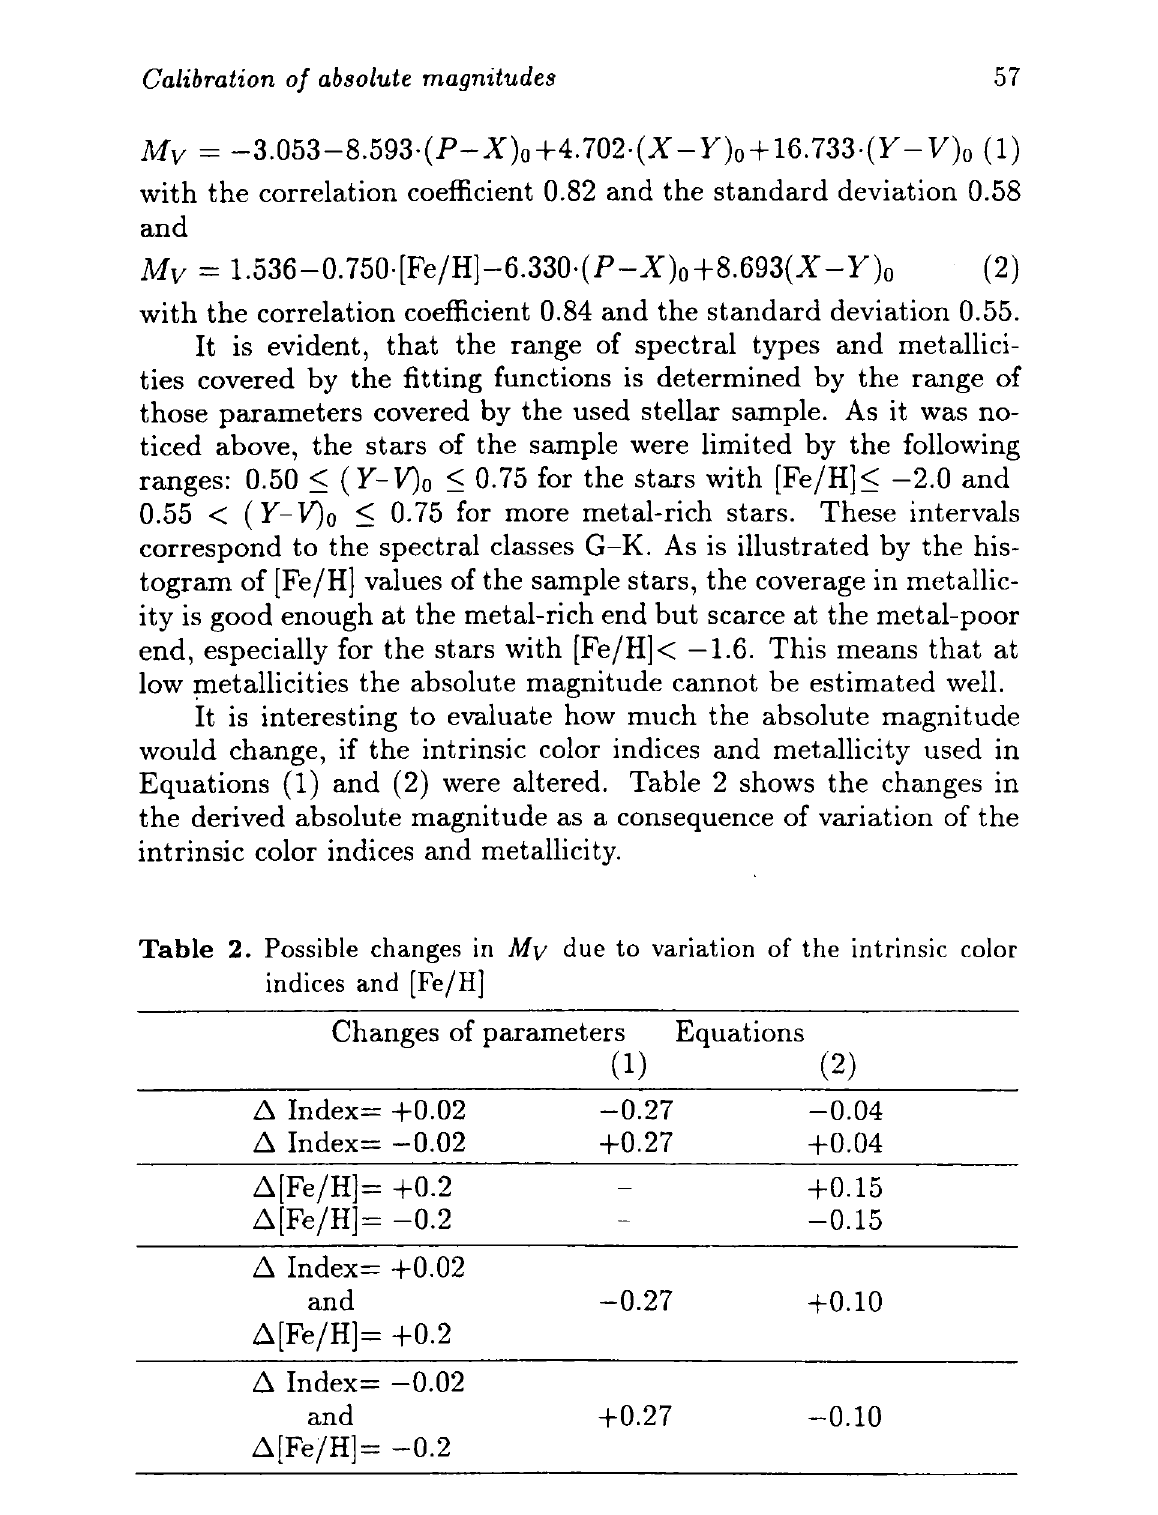
Table 2. Possible changes in My due to variation of the intrinsic color indices and